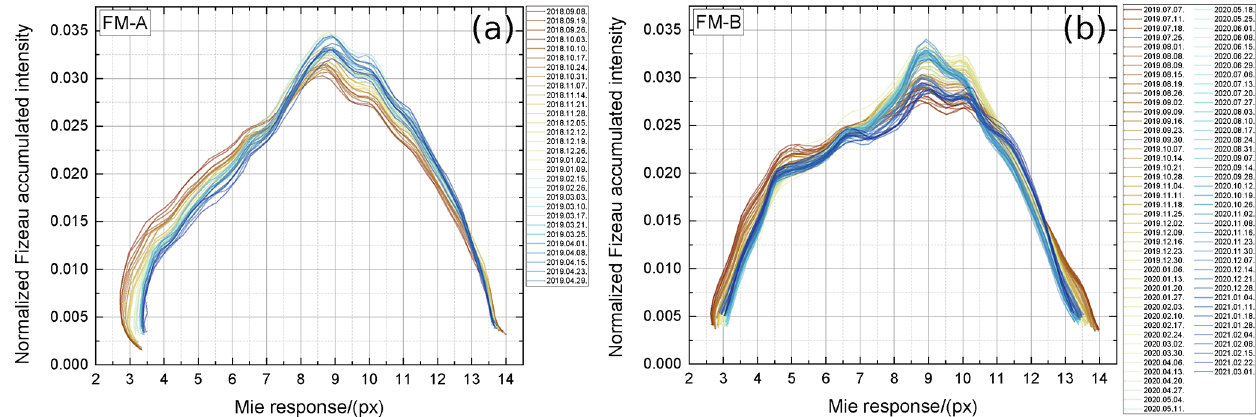
Figure 11. Integrated Fizeau intensity versus Mie response obtained during ISR measurements (see also Table 2) normalized to unit area for the FM-A (a) and the FM-B (b)